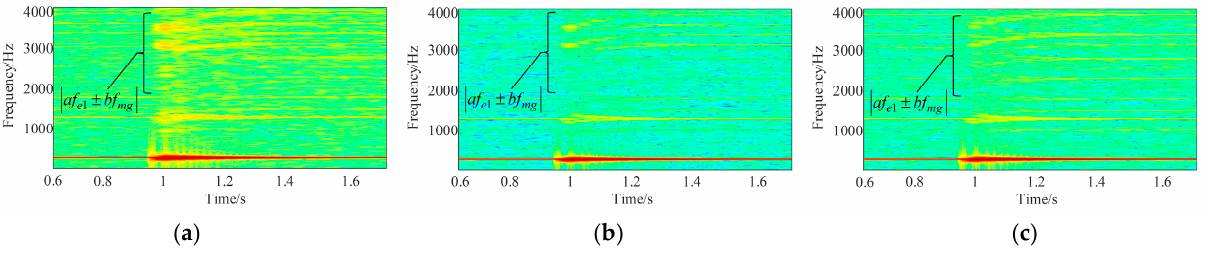
Figure 19. The meshing force of the first gear pair with different connection damping.